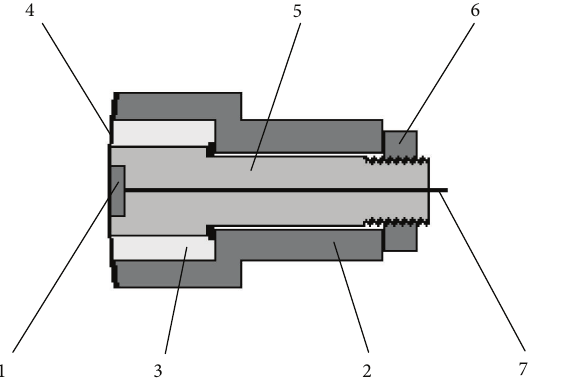
Figure2:Closedoxygensensor:(1)iscathode(Ag;5 mm 2 ),(2)isthe body-anode (Zn; 300 mm 2 ), (3) is electrolyte (KCl; 60g/L, 400 𝜇 L), (4)ismembrane(PE;50 𝜇 m,100mm 2 ),(5)isthebodyofthecathode (polymethyl methacrylate, PMMA), (6) is nut, and (7) is output to oximeter. The main feature of this oxygen sensor is accelerated gas exchange between the test liquid and electrolyte (3) through a polyethylene membrane (4). A small amount of electrolyte, the location of the total volume as close as possible to the membrane, and a large area of the membrane contribute the acceleration.